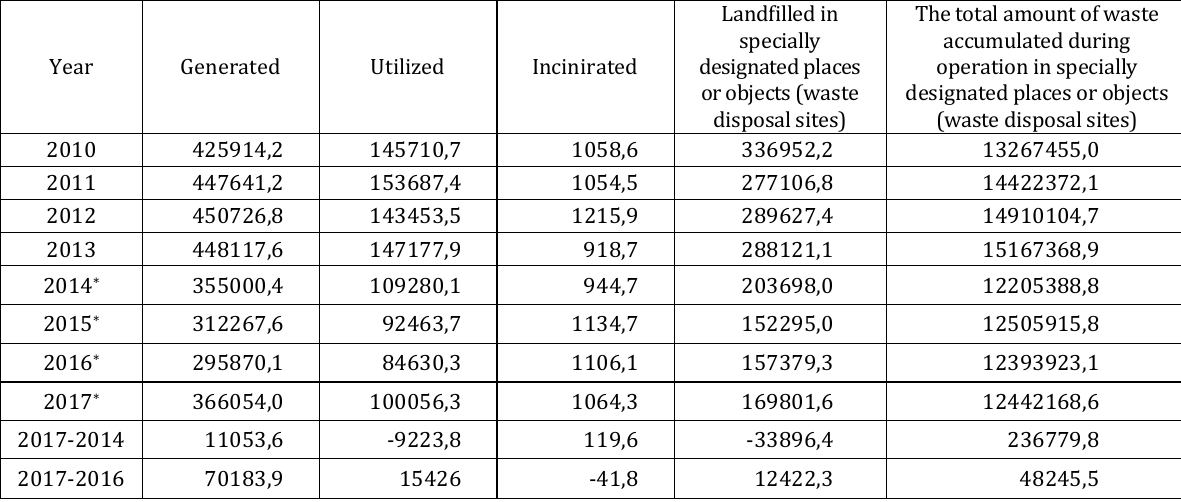
Table 2. Generation and management of I-IV hazard classes waste in Ukraine, thsd. t (Source: calculated by the author according to the State Statistics Committee of Ukraine) Year Generated Utilized Incinirated